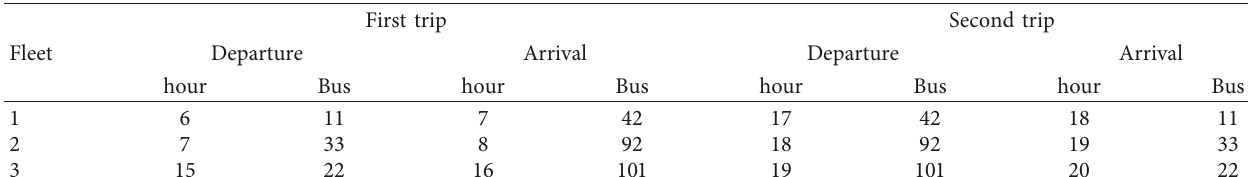
Table 4: Travel characteristics.